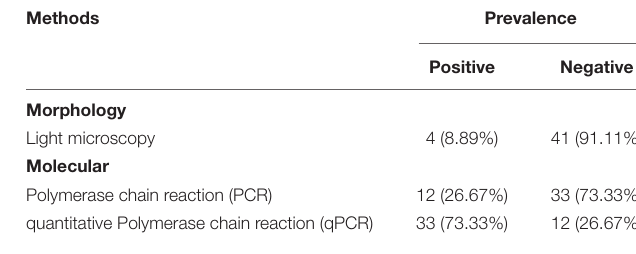
TABLE 1 | Comparison of microscopy and molecular